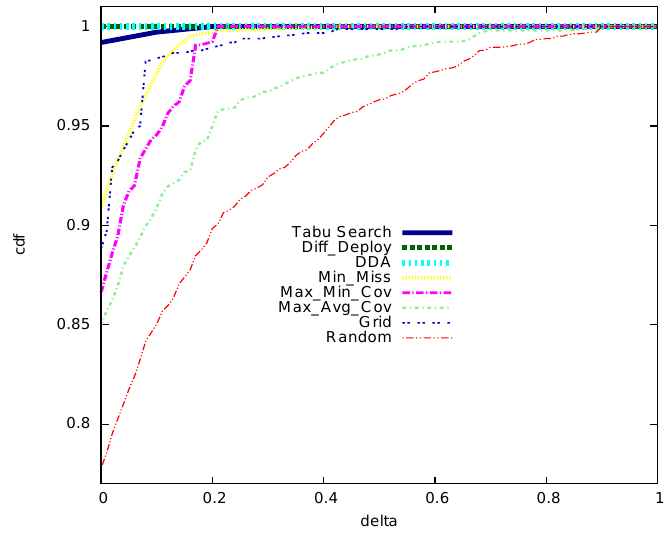
Figure 7. Tabu Search: Wireless communication network graph, R